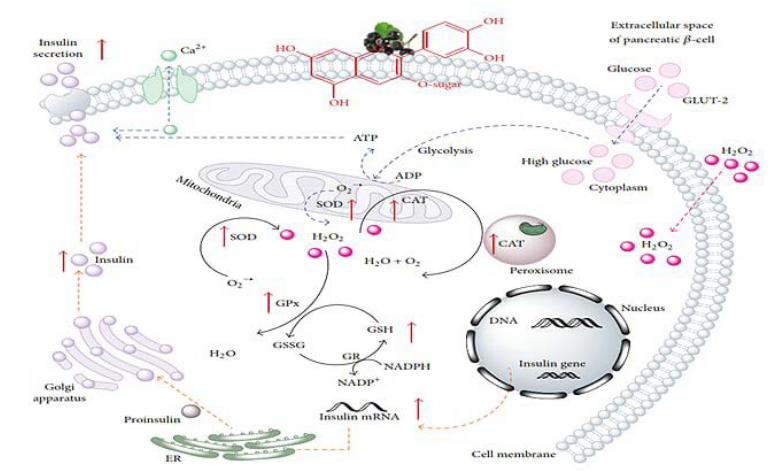
Figure 2. Schematic presentation of chokeberry anthocyanin-induced insulin secretion and antioxidant enzyme pathways in pancreatic β -cells under high-glucose-induced stress conditions. Glucose is transported across the cell membrane via glucose transporter (i.e., GLUT-2), followed by glycolysis and pyruvate production. Afterward, pyruvate is used for the generation of ATP in mitochondria. Here, in connection with the electron transport chain, radicals, like superoxide anion (O 2 • - ), are also produced and simultaneously neutralized by the enzymatic antioxidant SOD. SOD converts the O 2 • - into harmless O 2 and another radical H 2 O 2 . In addition to H 2 O 2 di ff usion through the cell membrane, H 2 O 2 is also scavenged by CAT and GPx resulting in water and oxygen production. Chokeberry-derived anthocyanins strengthen this inherent enzymatic antioxidant system (i.e., SOD, CAT, and GPx), which can more actively neutralize the radicals generated during glucose metabolism. H 2 O 2 -stimulated reduction of GSH is also ameliorated by chokeberry anthocyanins. Chokeberry anthocyanins also replenish the pool of insulin by increasing the insulin gene expression. Proinsulin, a precursor of insulin, folded in the endoplasmic reticulum, is transported to the Golgi apparatus. Chokeberry anthocyanins can also influence the opening of the voltage-gated Ca 2 + channels, leading to an increased fusion of insulin granules with the cell membrane (Source: Rugina et al.